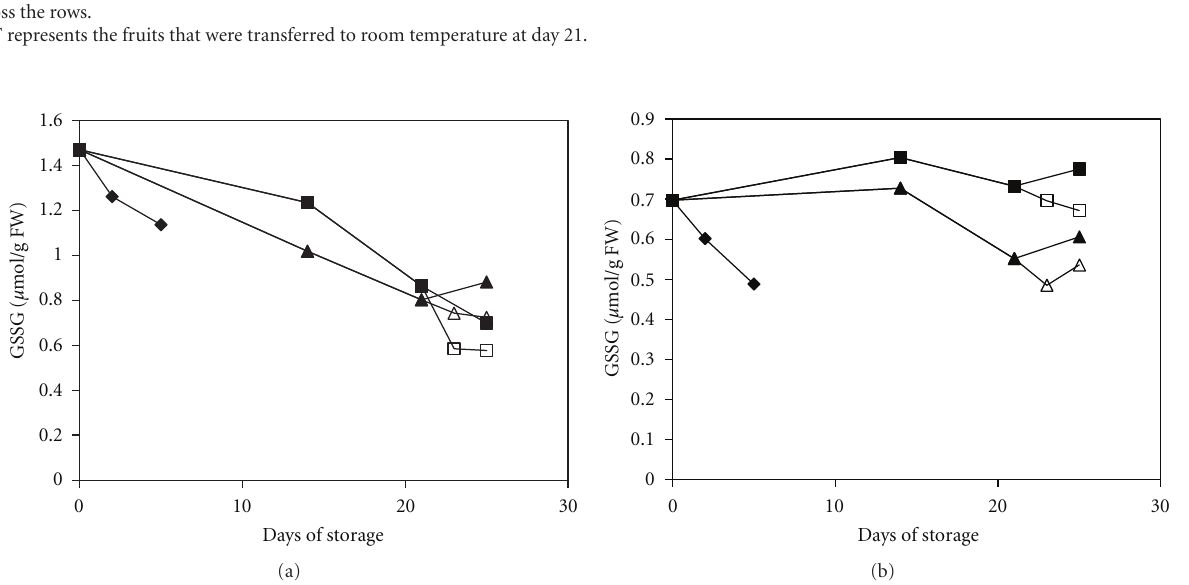
Figure 4: Changes in the GSSG of mature green peppers (a) and fully ripe/red peppers (b) for the UCRT ( (cid:2) ), MAP ( (cid:3) ), and MAP+1-MCP ( (cid:4) ) treatments during storage at 10 ◦ C; MAP ( (cid:5) ) and MAP+1-MCP ( (cid:6) ) values for the fruits transferred to room temperature at day 21. The values are the means of six replicate samples, and their S.E.s are